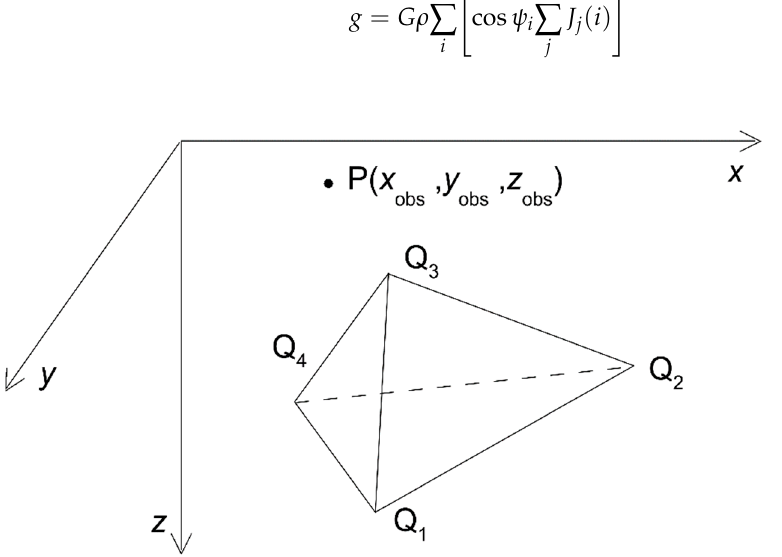
Figure 1. A tetrahedral cell in coordinate system.